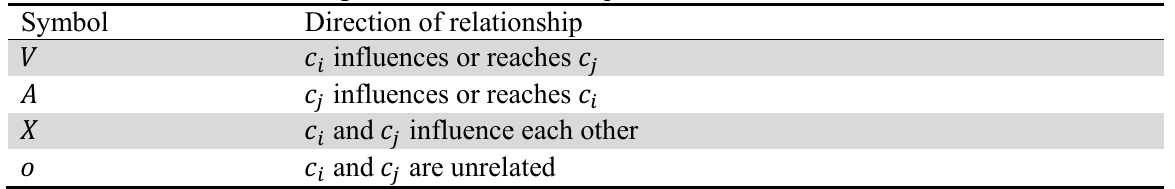
Nominal scale for establishing contextual